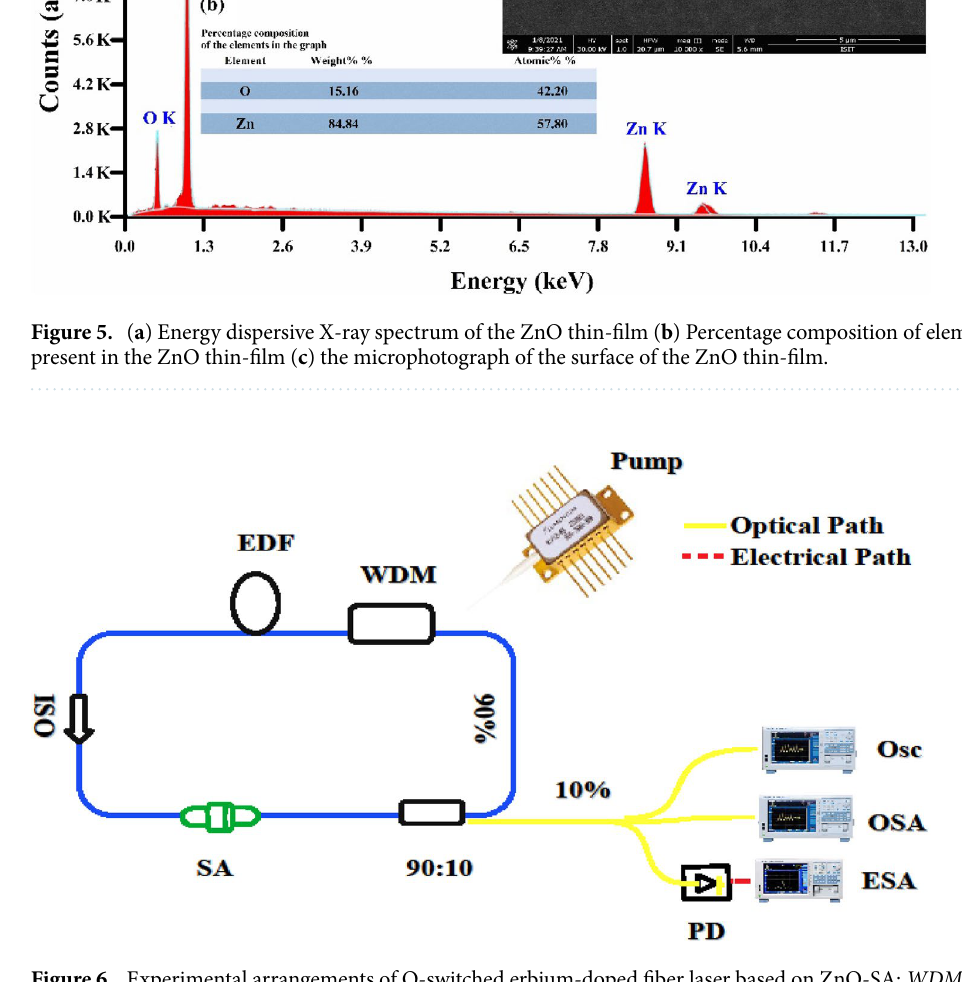
Figure 6. Experimental arrangements of Q-switched erbium-doped fiber laser based on ZnO-SA; WDM Wavelength Division Multiplexer, EDF Erbium-doped fiber, ISO Optical isolator, PD Photodiode, PM Power meter, ZnO-SA Zinc-oxide saturable absorber, Osc Oscilloscope, OSA Optical spectrum analyzer, ESA Electric spectrum